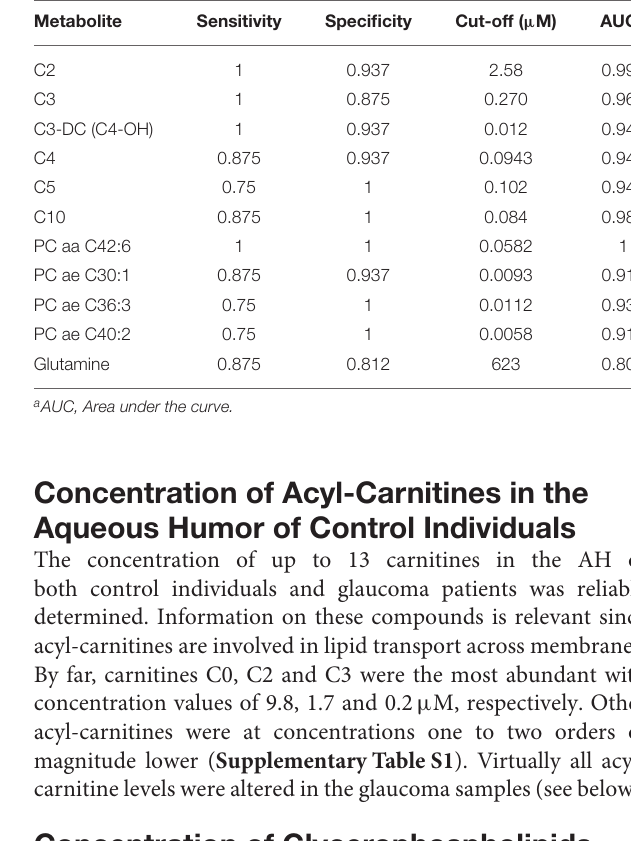
( Supplementary Table S1 ). Regarding glycerophospholipids, their levels ranged between 0.14 µ M (C34:1 phosphatidylcholine) and 0.0025 µ M (C40:2 phosphatidylcholine). Surprisingly, except for glycerophospholipid C36:6 and sphingomyelin SM C22:3, the levels of all detectable glycerophospholipids and sphingomyelins were significantly altered in glaucoma samples